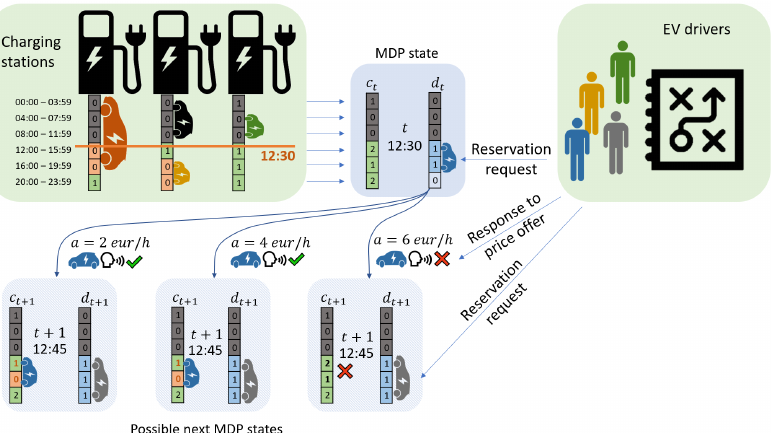
Figure 1. Illustration of the MDP states. The blue squares represent the MDP states. At timestep t , the capacity of the charging station is expressed by the capacity vector c t . Elements of the vector represent available charging capacity in corresponding timeslots (time ranges in the green square). Possible charging session reservation request arriving since the previous timestep is expressed by the vector d t , with ones representing the requested timeslots. Based on the three state variables c t , t , d t , the pricing policy provides an action a , the price for charging, that the user either accepts (the first two states at the bottom) or rejects (the state on the right). The state then transitions into the next timestep (details of the transition function are illustrated by Figure 2). The accepted charging request leads to reduced capacity values. The next charging session reservation is entered into the new state. Note that the timesteps have much finer resolution than the charging timeslots. The gray color is used to show past information regarding the charging capacity and session vectors c t and d t